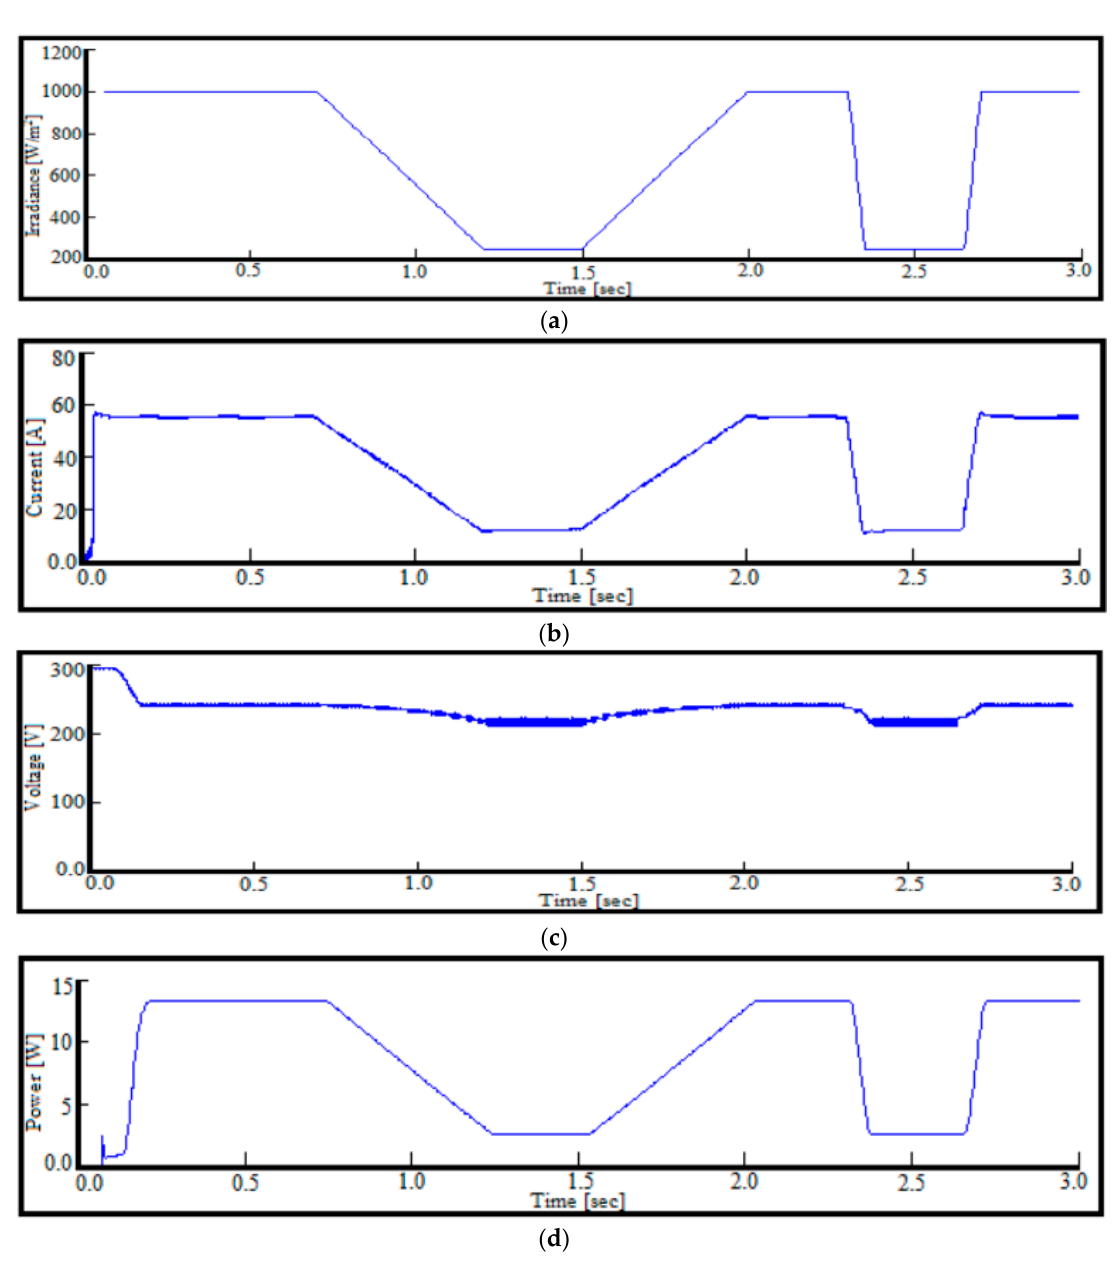
Figure 24. ( a ) Irradiance vs. Time of P&O at PV side; ( b ) Current vs. Time of P&O at PV side; ( c ) Voltage vs. Time of P&O at PV side; ( d ) Power vs. Time of P&O at PV side.